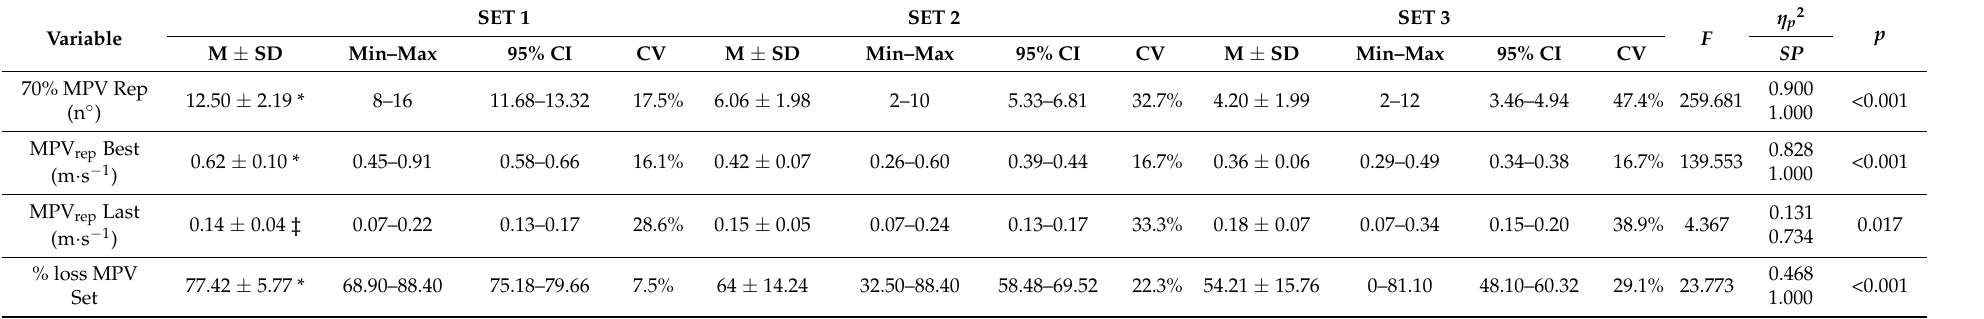
Table 1. Descriptive data of the different variables in the bench press exercise protocol of the total group of participants ( n =